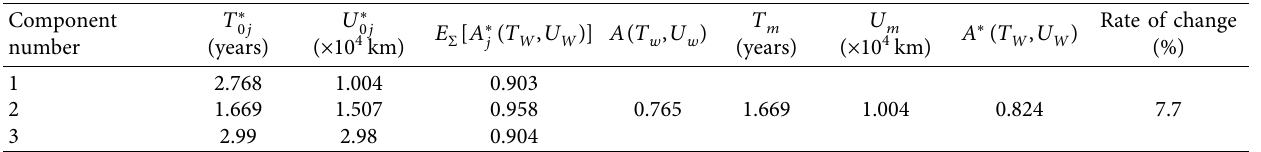
Table 5: Maximal availability before and after grouping maintenance.